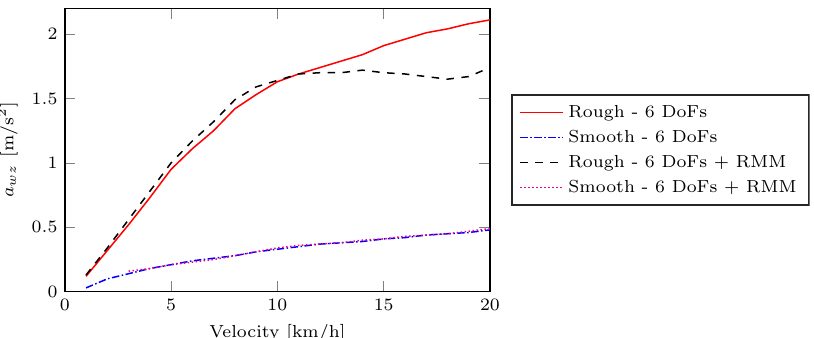
Figure 14. The effect of the forward speed on the root mean square value of the vertical acceleration a wz of the